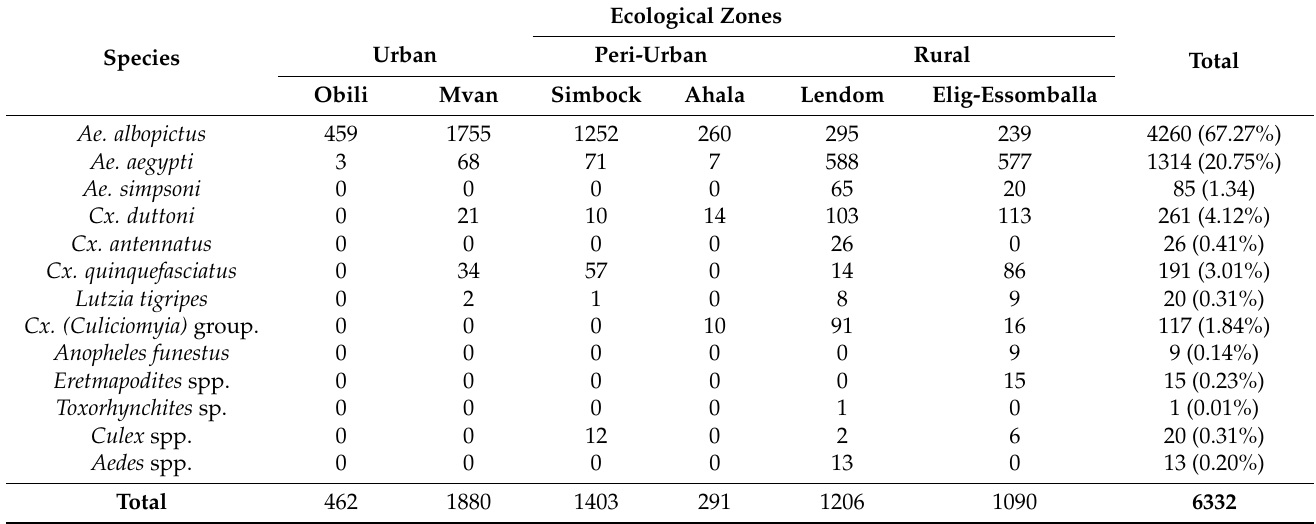
Table 1. Mosquito species identified across the transect from urban, peri-urban and rural areas.